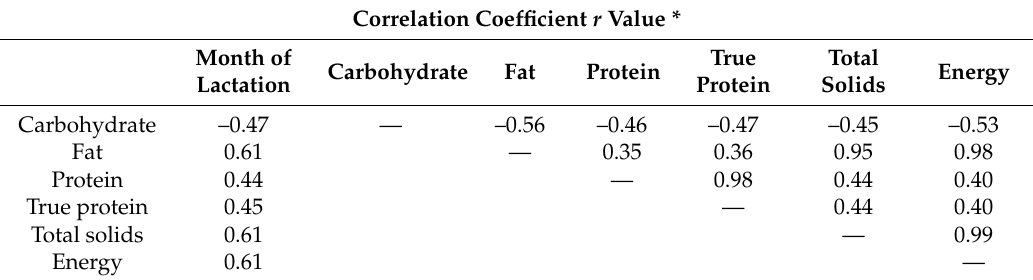
Table 3. Correlations among macronutrients over prolonged lactation from the 1st to the 48th